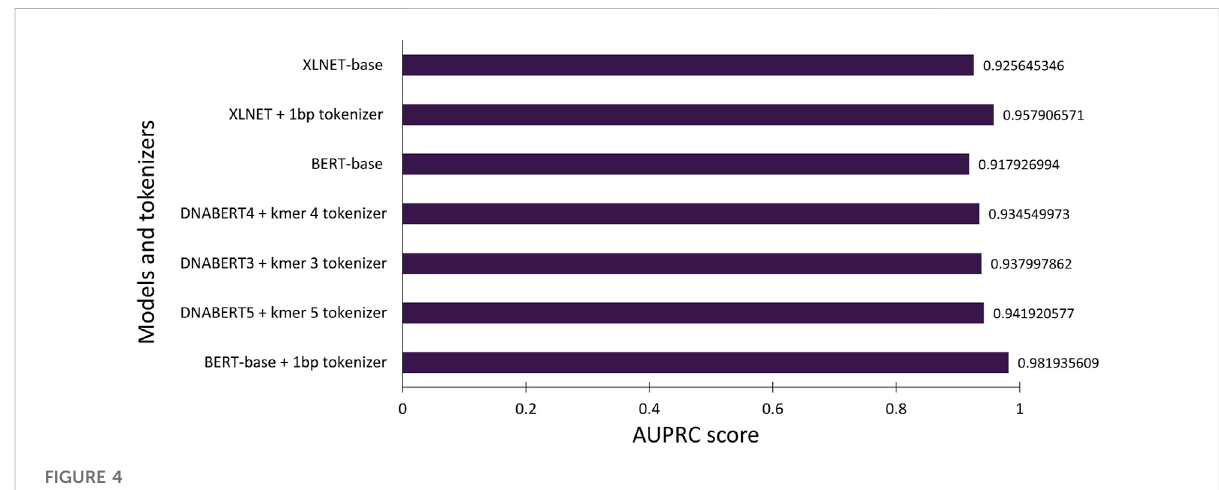
FIGURE 4 Average precision scores of the tested transformer-based models.